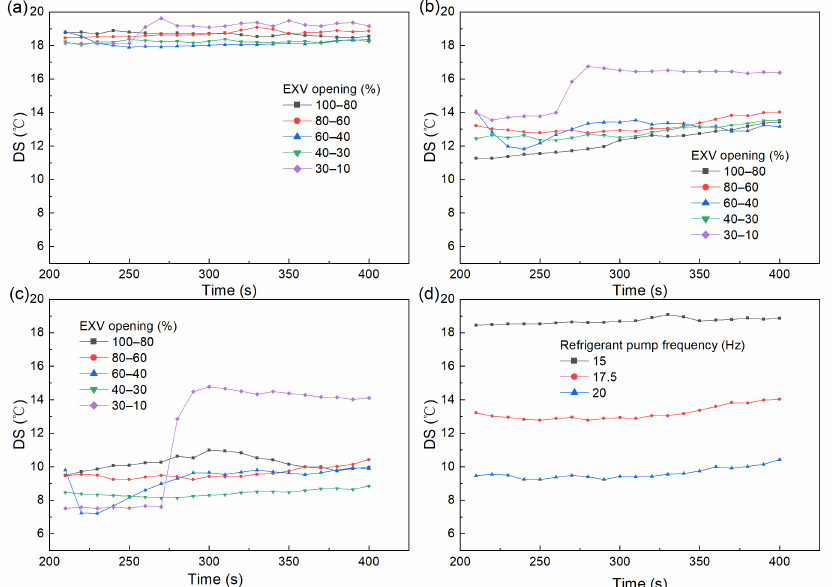
Figure 4. Change curves of DS when the refrigerant pump opening is 60% ( a ) the refrigerant pump frequency is 15 Hz, and the EXV1 opening is 100%–10%; ( b ) the refrigerant pump frequency is 17.5 Hz, and the EXV1 opening is 100%–10%; ( c ) the refrigerant pump frequency is 20 Hz, and the EXV1 opening is 100%–10%; ( d ) the EXV1 opening is 80%–60%, and the refrigerant pump frequency is 15 Hz, 17.5 Hz, and 20 Hz, respectively.